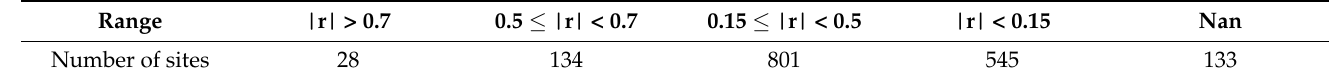
Table 3. Distribution of correlation coefficient (CC) values among 1641 sites.